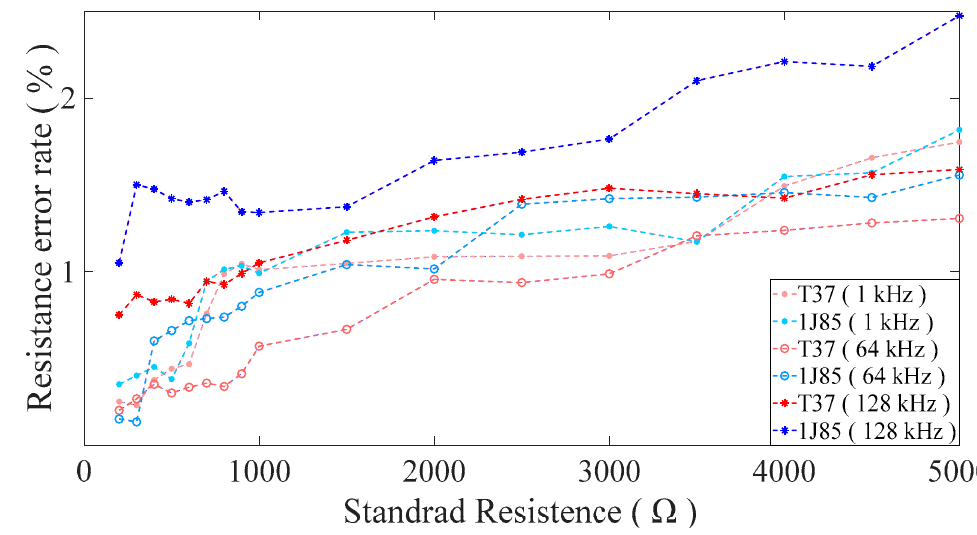
Figure 5. The impedance error rate of different sensors under different frequencies.